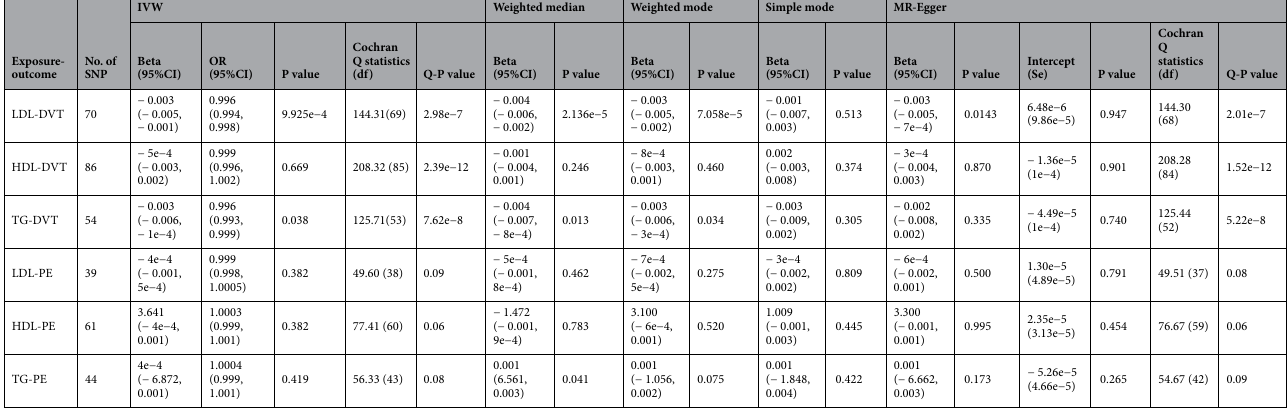
Table 1. MR estimates from different methods of assessing the causal effect of classical lipids on VT. Se standard error, SNP single nucleotide polymorphism, MR Mendelian randomization, IVW inverse variance weighting, VT venous thromboembolism, PE pulmonary embolism, DVT deep venous thrombosis, LDL Low density lipoprotein, HDL High-density lipoprotein, TG triglyceride, CI confidence